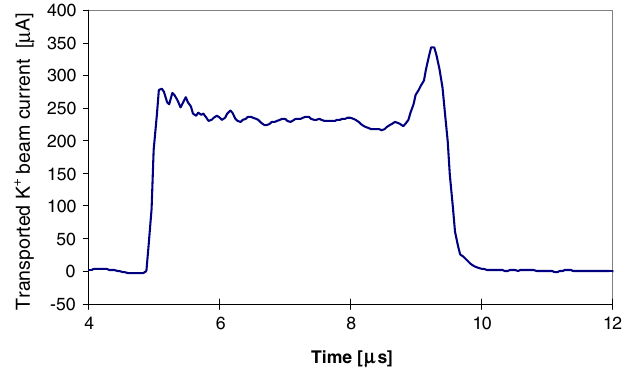
FIG. 10. (Color) Transported K (cid:1) beam current as a function of time derived from summing the detector slit data. The total HCX beam current pulse as measured by a Faraday cup is flat; the peaks at the head and tail of the detector signal may be related to variations in beam size at the head and tail of the pulse.